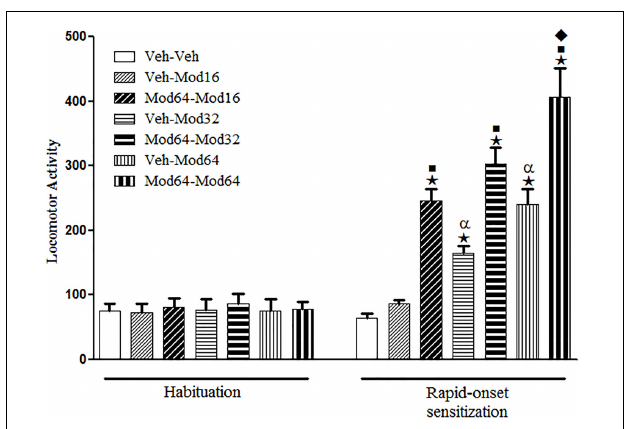
FIGURE 1 | Locomotor activity during the 3rd day of habituation and during the challenge session of the rapid-onset behavioral sensitization test. The animals received a priming injection of vehicle (Veh-) or 64 mg/kg modafinil (Mod64-) and, after 4 h, a challenge injection of vehicle (-Veh) or 16 mg/kg (-Mod16), 32 mg/kg (-Mod32), or 64 mg/kg modafinil (-Mod64). After 30 min, the locomotor activity was measured for 10 min in the open field. Data are reported as mean ± SEM ( n = 12). (cid:70) P < 0.05 compared with the Veh-Veh group. (cid:4) P < 0.05 compared with the respective control group, which received a priming injection of vehicle. α P < 0.05 compared with the Veh-Mod16 group. (cid:117) P < 0.05 compared with all of the other